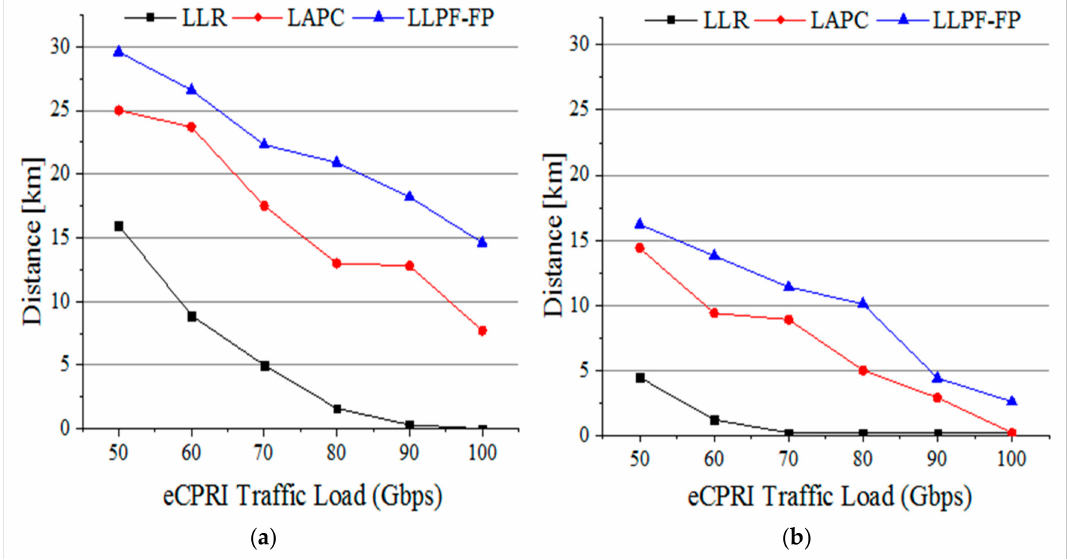
Figure 7. Fronthaul distances supported by the di ff erent schemes for the ( a ) COST239; and ( b )